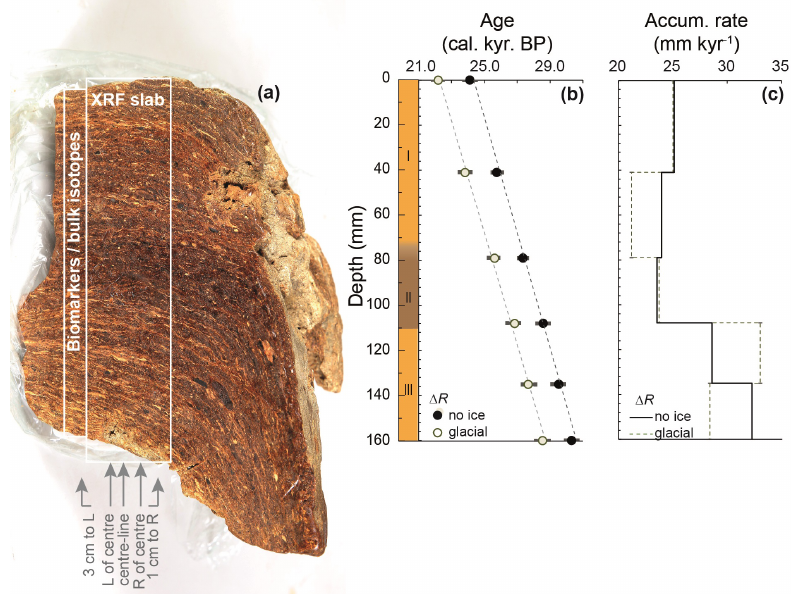
Figure 2. Stomach-oil deposit WMM7 stratigraphy and the two age–depth models explored in Sect. 2.2 and Table 1. (a) Cross-section of the section used for subsampling, scaled with panels (b) and (c) . Note the clear laminae, which slope to the right away from the main slab. A zone of darker brown and less well-defined laminae is found in the central section (Unit II in panel b ). A 5cm wide slab was cut for XRF analysis. Data from the centreline scan are shown in Fig. 3 and used for statistical analysis. The results of additional scans to the left and right of centre and from two new cuts (3cm left, 3cm right; see arrows) are shown in Fig. A1. Biomarker and bulk stable isotope samples were taken immediately to the left of the XRF slab. (b) Three-unit stratigraphy and two age–depth models constrained by six bulk radiocarbon dates, calibrated using either a Holocene “no sea ice” (cid:49)R or a glacial-stage “maximum sea ice” (cid:49)R (see Table 1 for 14 C calibration). Figures 3–6 apply the Holocene “no ice” (cid:49)R age model; (c) accumulation rate between age control points for the two age–model scenarios. Linear interpolation was applied to generate an age–depth model for all sampling